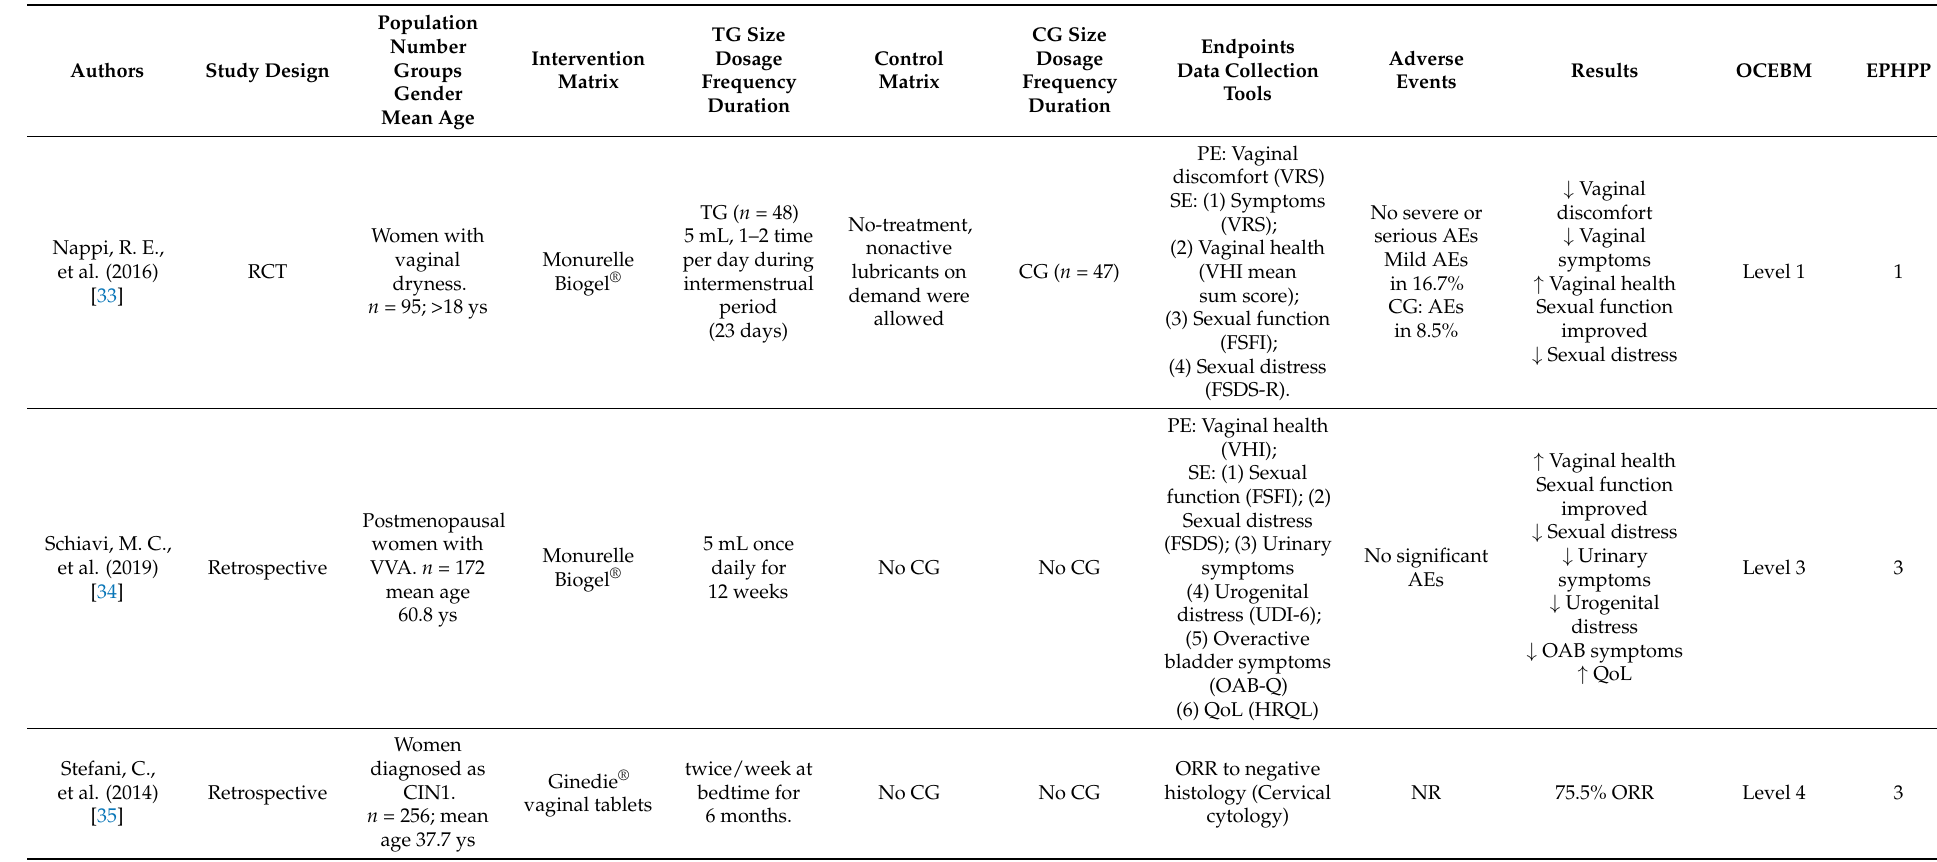
Table 2. BC topical applications in uro-gynecology